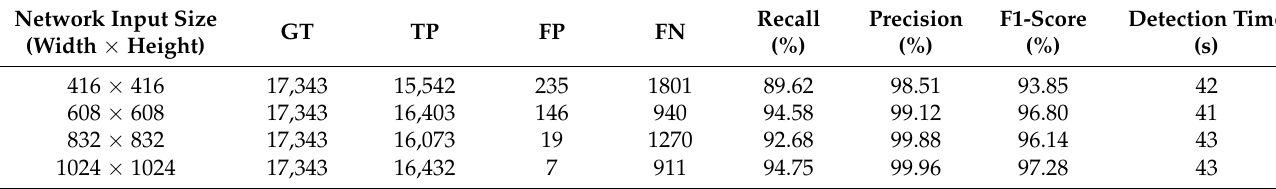
Table 10. YOLOv3 model evaluation results.